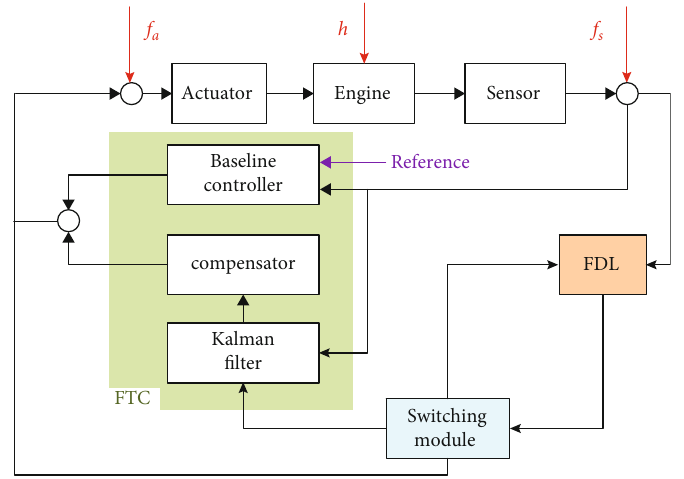
Figure 3: The proposed schematic of the improved hybrid FTC structure.